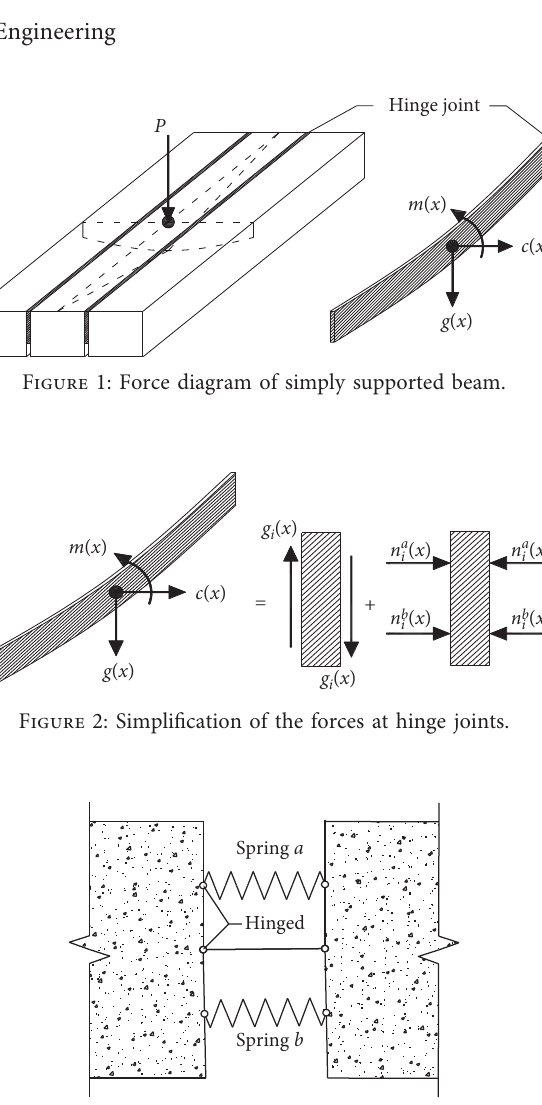
Figure 3: Hinge joint model.